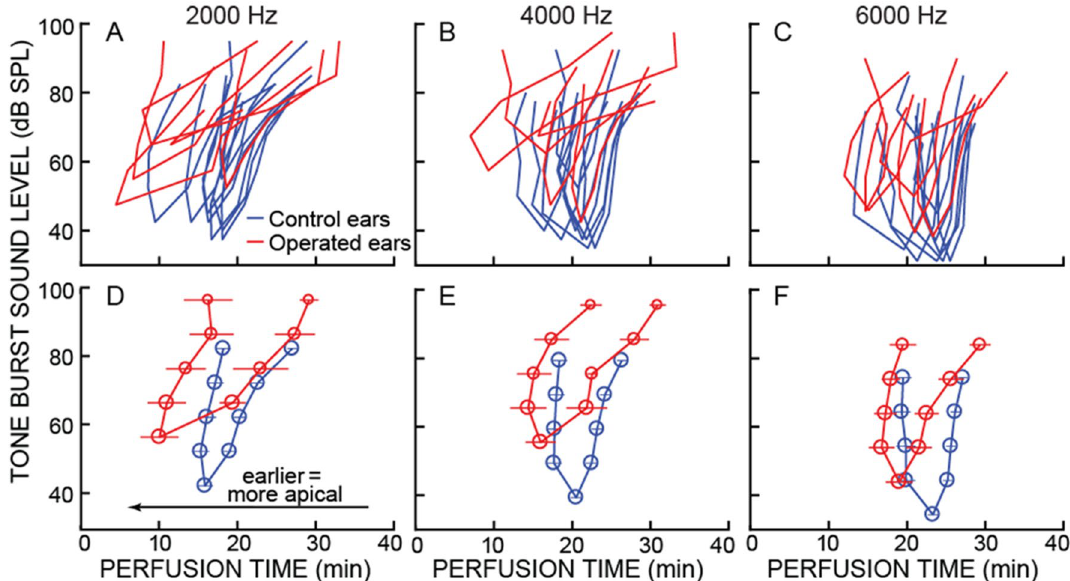
Figure 2. CAP response-reduction-time tuning curves (TCs). Shown are data from the three tone-burst frequencies that, in Fig. 1C,D, had statistically-significant differences between operated and control ears at the 50% reduction points of the 10 dB SL CAPs (the lowest y-axis value of each TC). TC edges are from tone-burst levels that were increased in 10 dB steps above the 10 dB SL point, and show the perfusion times that reduced CAP amplitudes to 80% (left, earlier edge) and 20% (right, later edge) of their pre-perfusion amplitudes. ( A–C ) Each line is the TC from one ear: red = operated ears, blue = control ears. ( D–F ) Lines show the averages of the data from panels A-C. For each group, averages were done across all of the reduction times at a given SL. Large circles indicate the averages are from all ears of a group; medium circles are averages from 4 ears, small circles are averages from 3 ears. Error bars represent 1